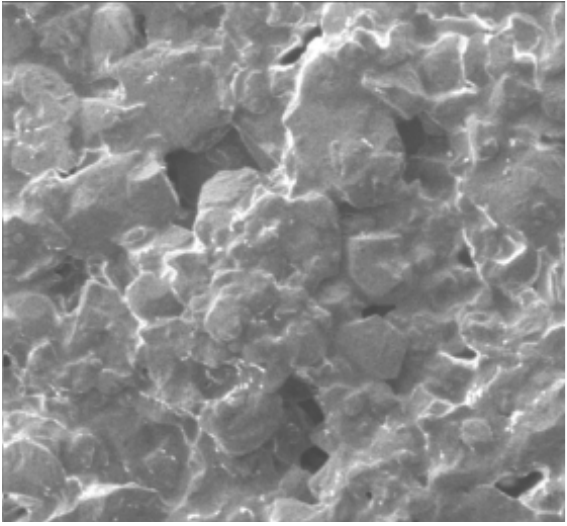
Figure 13. FIB micrograph of surface view of MnZn ferrite